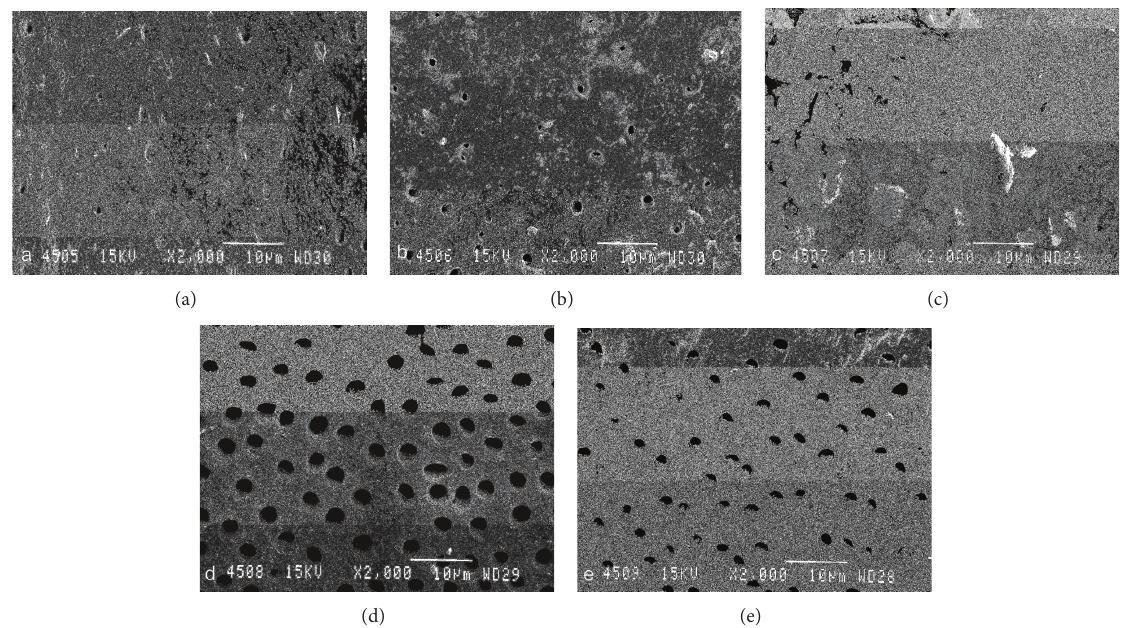
Figure 2: Photomicrographs of root canal wall in each group after final cleaning protocols (original magnification: 2000x; scalebar is 10 𝜇 m). Images (a)–(e) show canal walls at 1, 3, 6, 8, and 12 mm from the apex. In groups 1 and 6, a typical amorphous smear layer on root canal wall, with limited opening of the dentinal tubules, was observed up to 3 mm from the apical preparation point. At 6 mm, remnants of debris and smear layer were observed. (a) is at 1mm from the apex and (e) is at 12 mm from the apex.